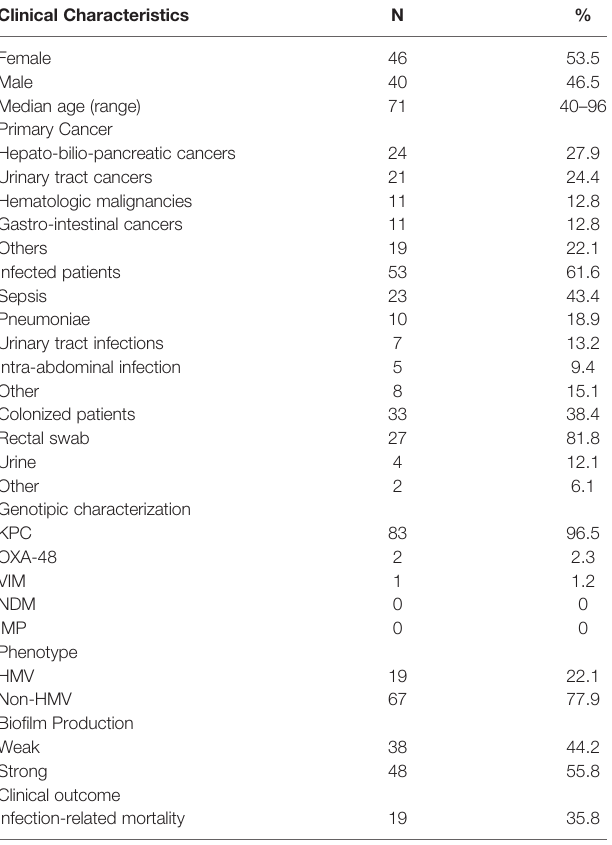
TABLE 1 | Demographic and clinical characteristics of patients at